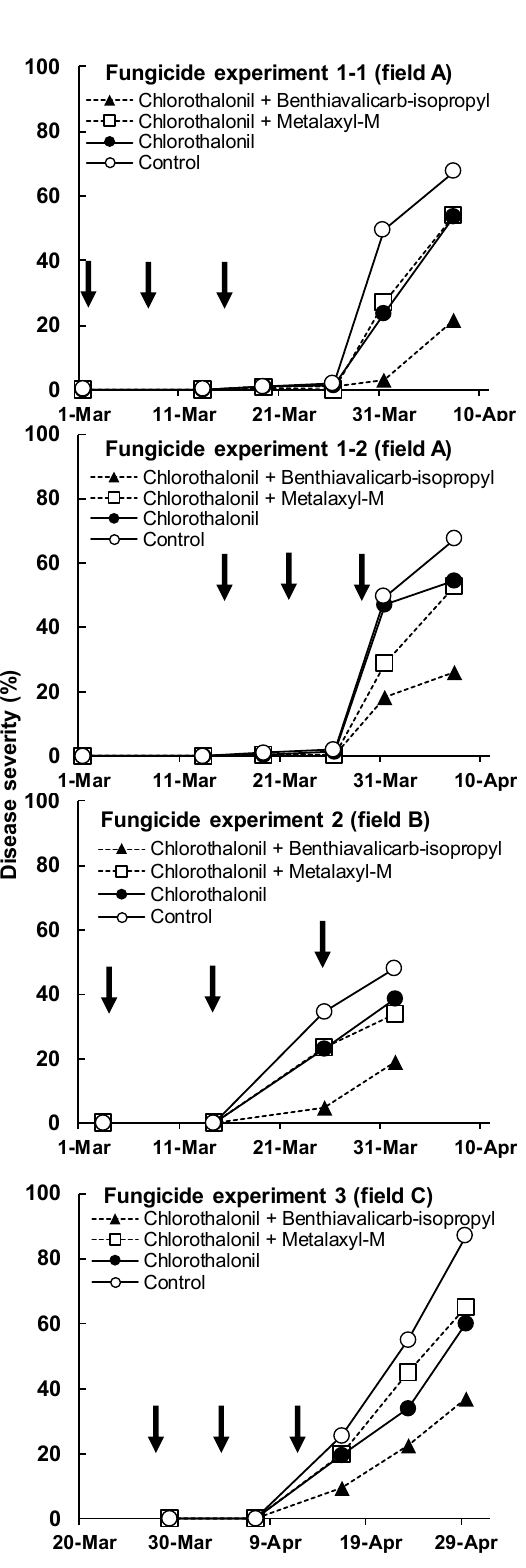
Figure 9. Effects of fungicide treatments on onion downy mildew in 2016. The arrows indicate the spray dates.